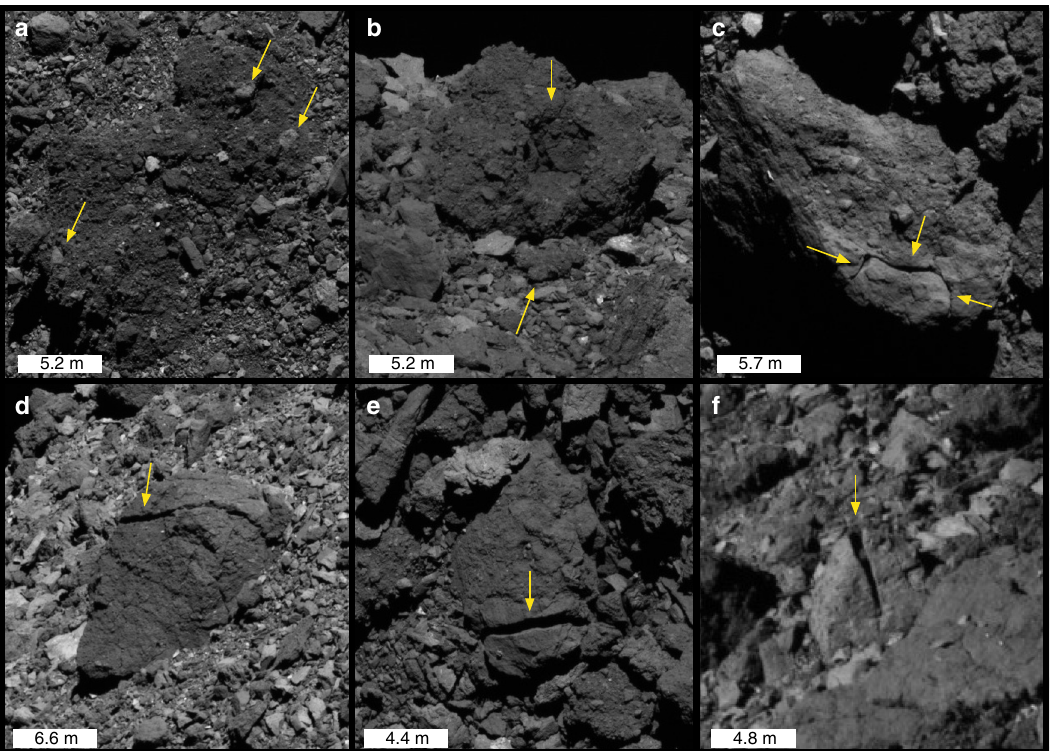
Fig. 2 Other signs of boulder breakdown on Bennu. Examples of disaggregation ( a – c ) and linear through-going fractures ( d – f ) in boulders of varying size. The orientation of linear fractures are in the ( d ) WNW-ESE and ( e , f ) N – S